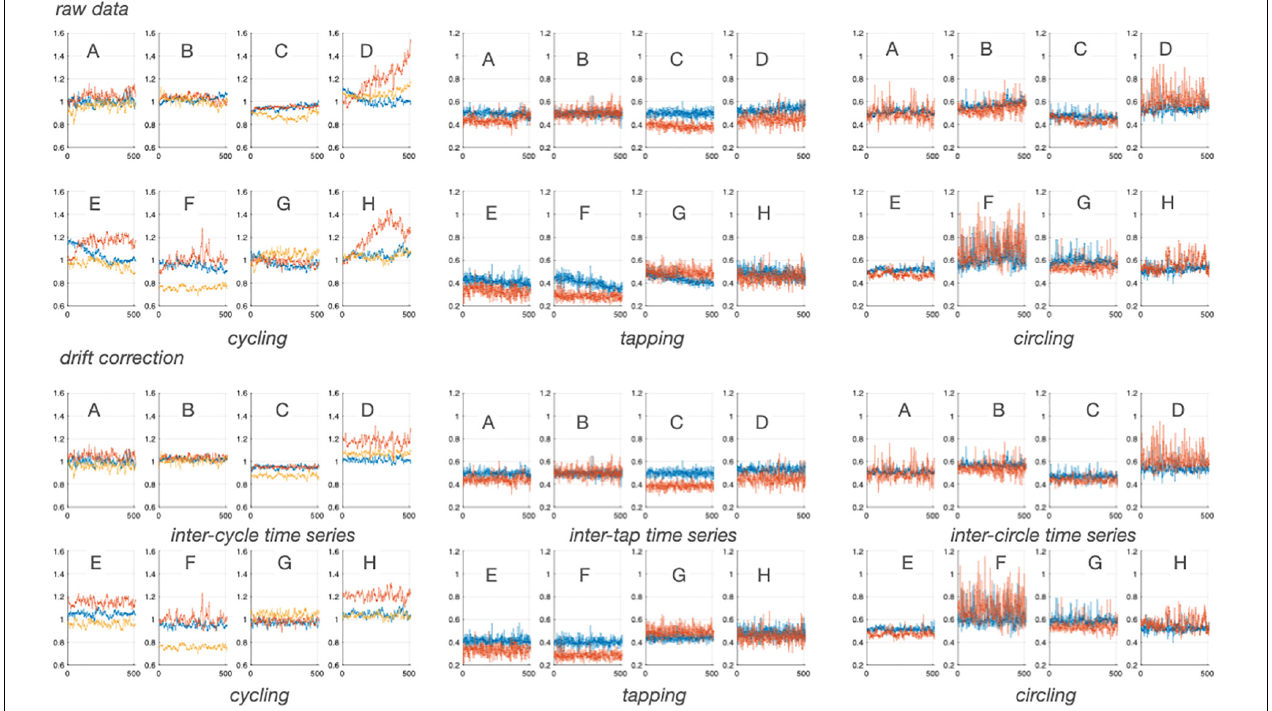
FIGURE 2 | Experimental time series before (upper panels) and after (bottom panels) drift removal obtained in each participant (A–H) . Blue lines are single task series. Red lines are cycling+tapping in left panels and tapping+cycling and circling+tapping in right panels. Yellow lines are cycling+circling.